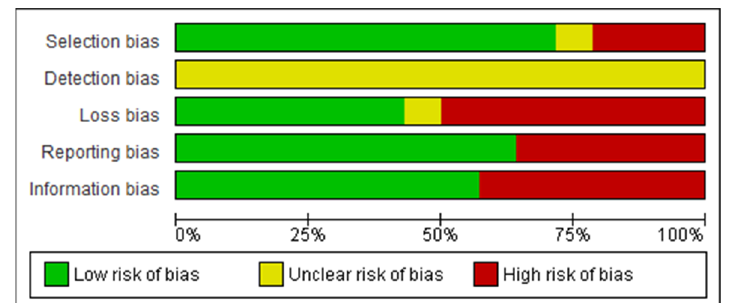
Figure 2. Graph of risk analysis of general bias in articles.